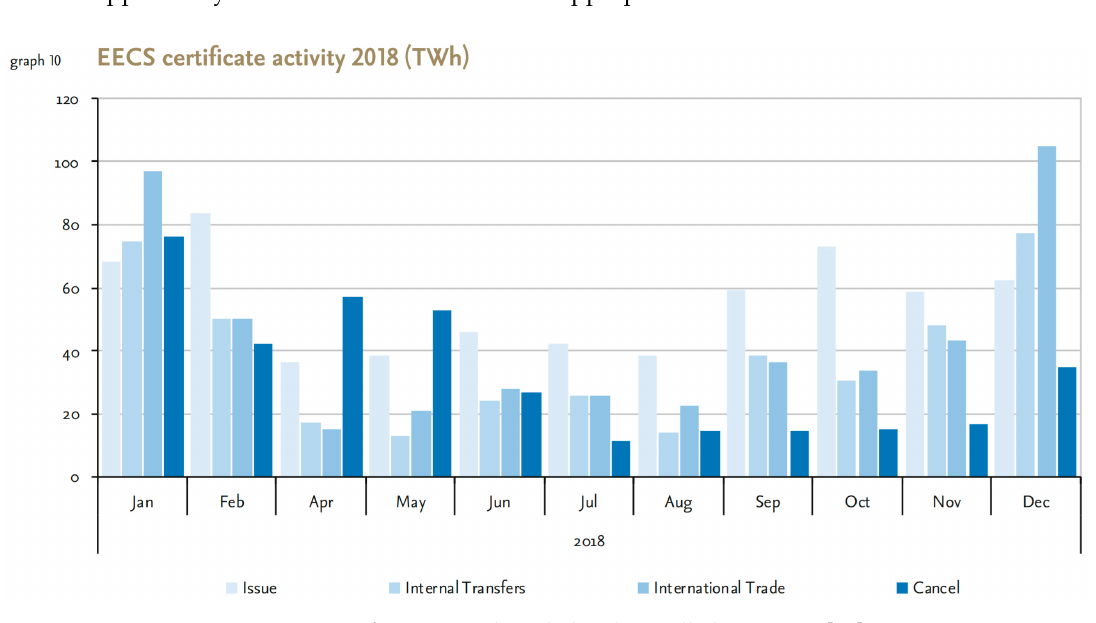
Figure 3. Certificates issued, traded and cancelled in Europe [17].